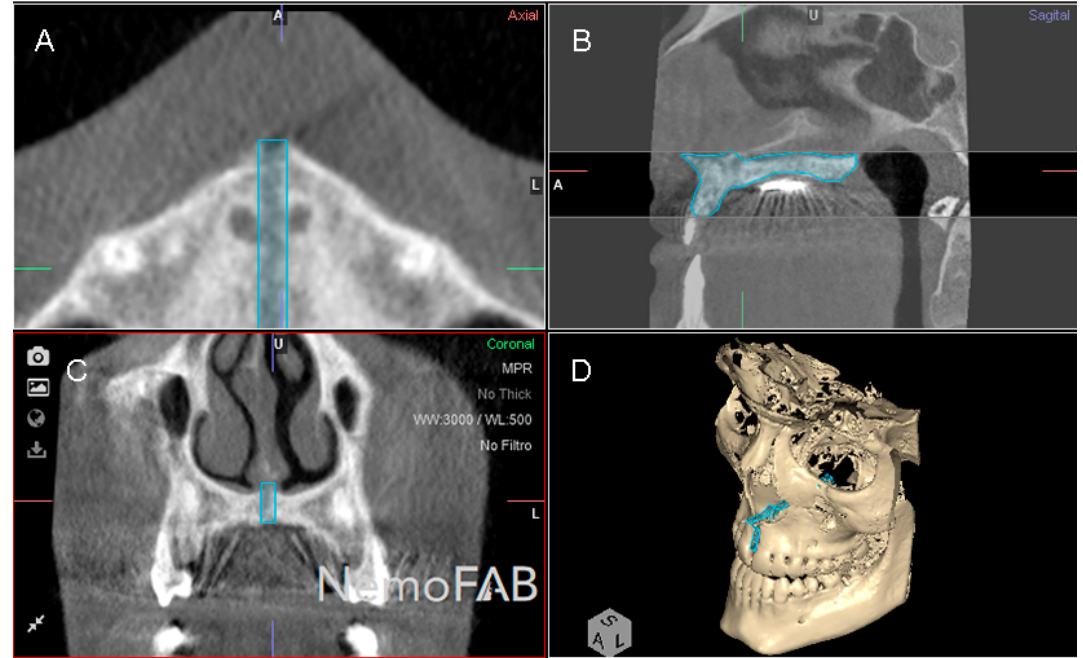
Figure 3. ( A ) Boundaries of the palatine suture (blue line) after the RME procedure through McNamara appliance was performed, at transversal plane, ( B ) sagittal plane, ( C ) coronal plane and ( D ) at three-dimensional reconstruction of the CBCT